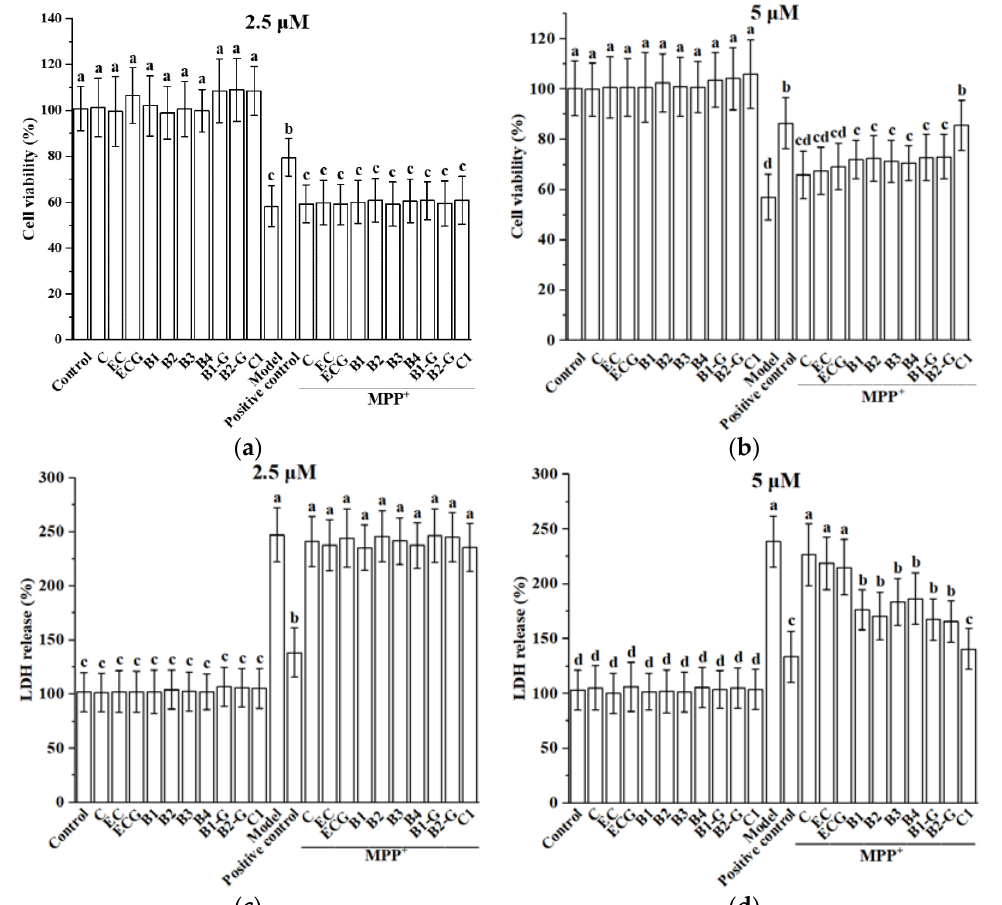
Figure 2. Effect of different structural procyanidins on MPP + -induced PC12 cell damage. ( a ) Effect of 2.5 µ M procyanidins with different structures on the survival of MPP + -injured PC12 cells. ( b ) Effect of 5 µ M procyanidins with different structures on the survival of MPP + -injured PC12 cells. ( c ) Effect of 2.5 µ M procyanidins with different structures on MPP + -induced LDH release. ( d ) Effect of 5 µ M procyanidins with different structures on MPP + -induced LDH release. Control, Blank control group; Model, MPP + (1.5 mM); Positive control, Deprenyl (30 µ M) + MPP + (1.5 mM). Data are expressed as the mean ± SD. All experiments were conducted six times. Different letters (a–d) on the bar represent significant differences, while the same letters represent no significant differences ( p < 0.05, one-way